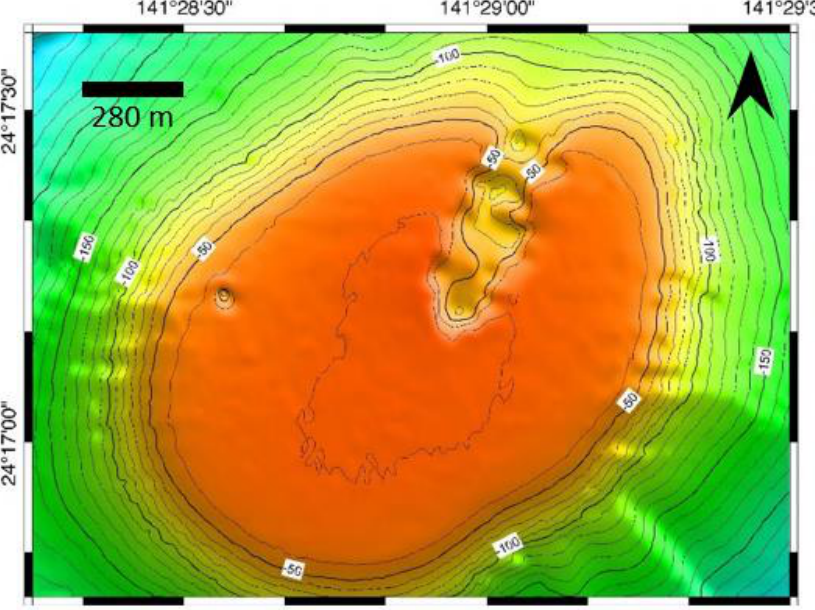
Figure 1. Topography map of submarine Niijima Fukutoku-Okanoba (NFO) after the 2010 eruption showing the bathymetric volcanic structure, modified from the map courtesy of the Japan Coast Guard [12].